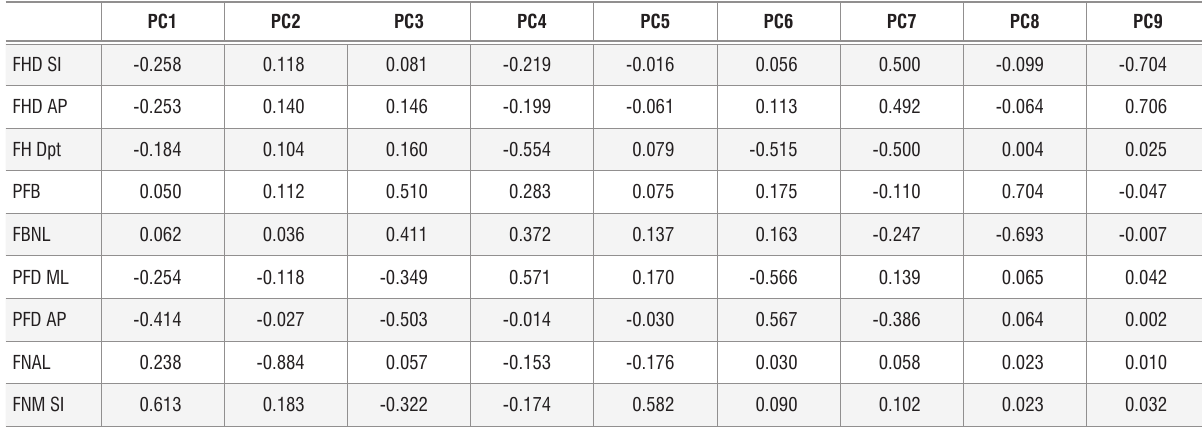
Component loadings for the principal components (PC) analysis of the proximal femur: pooled-sample shape